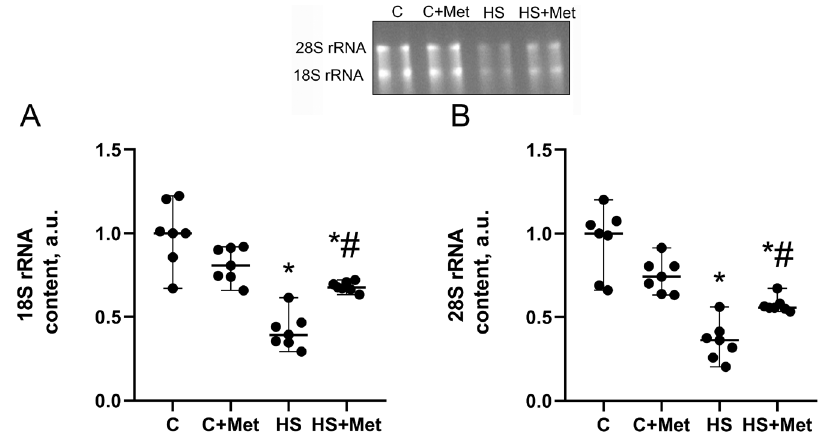
Figure 8. Effect of metformin pre-treatment on 18S rRNA content ( A ) and 28S rRNA content ( B ) in rat soleus muscle. C, vivarium control, C+Met, vivarium control + metformin pre-treatment, HS, 7-day hindlimb suspension, HS+Met, metformin pre-treatment + 7-day hindlimb suspension. Scatter dot plots indicate median values, and the whiskers represent minimum and maximum values; n = 7–8/group. *: p < 0.05 vs. C, #: p < 0.05 vs. HS.